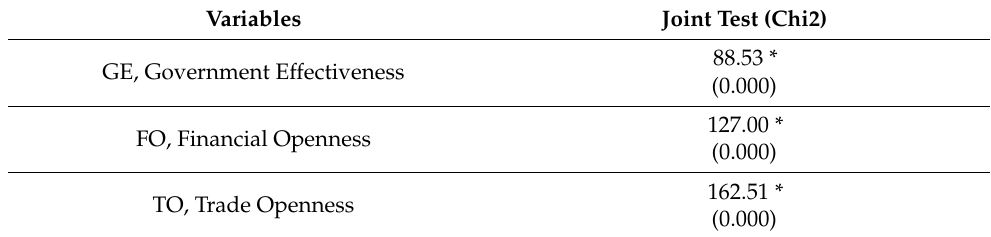
Table 2. Doornik–Hansen normality test